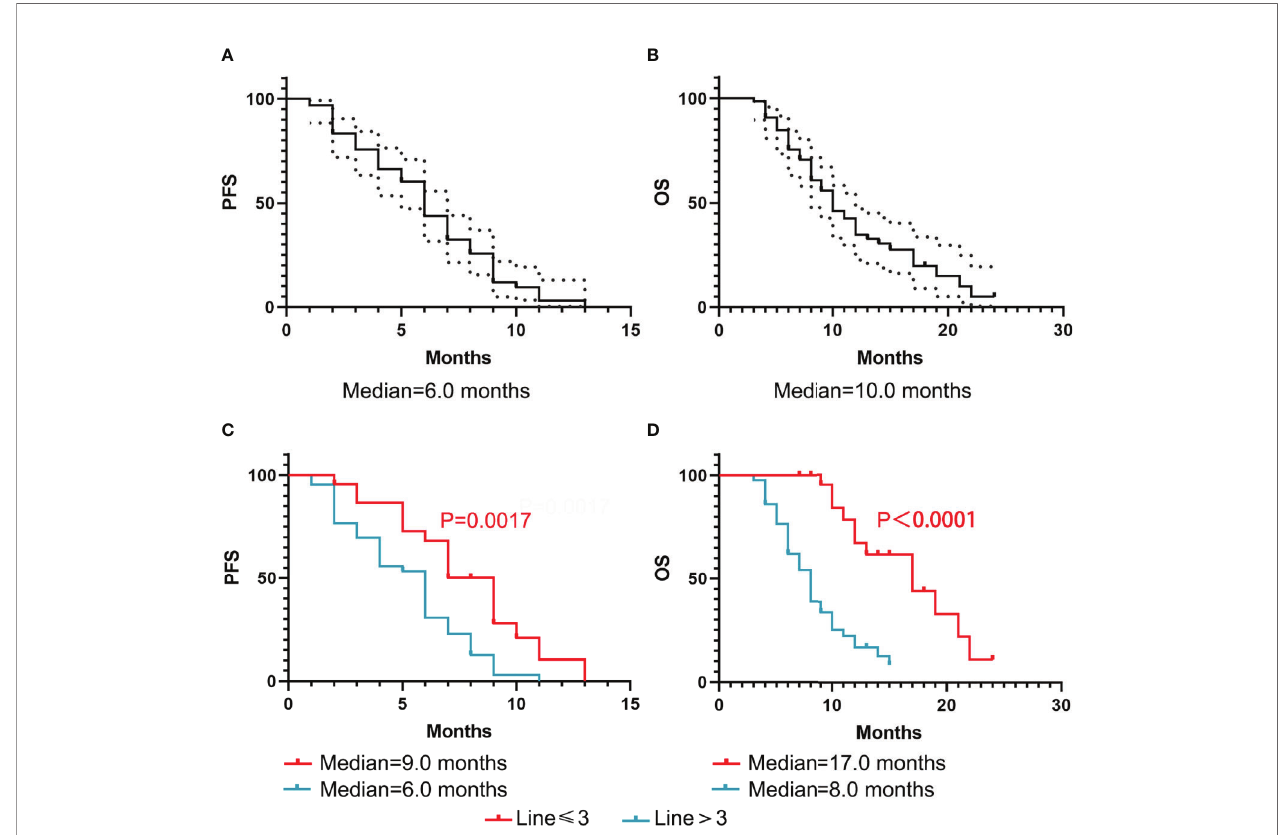
FIGURE 1 | Kaplan – Meier curve of PFS and OS for all 66 patients. (A, B) Black-dotted lines represent 95% con fi dence intervals (CIs). (C, D) The association with the number of prior chemotherapy regimens and DFS and